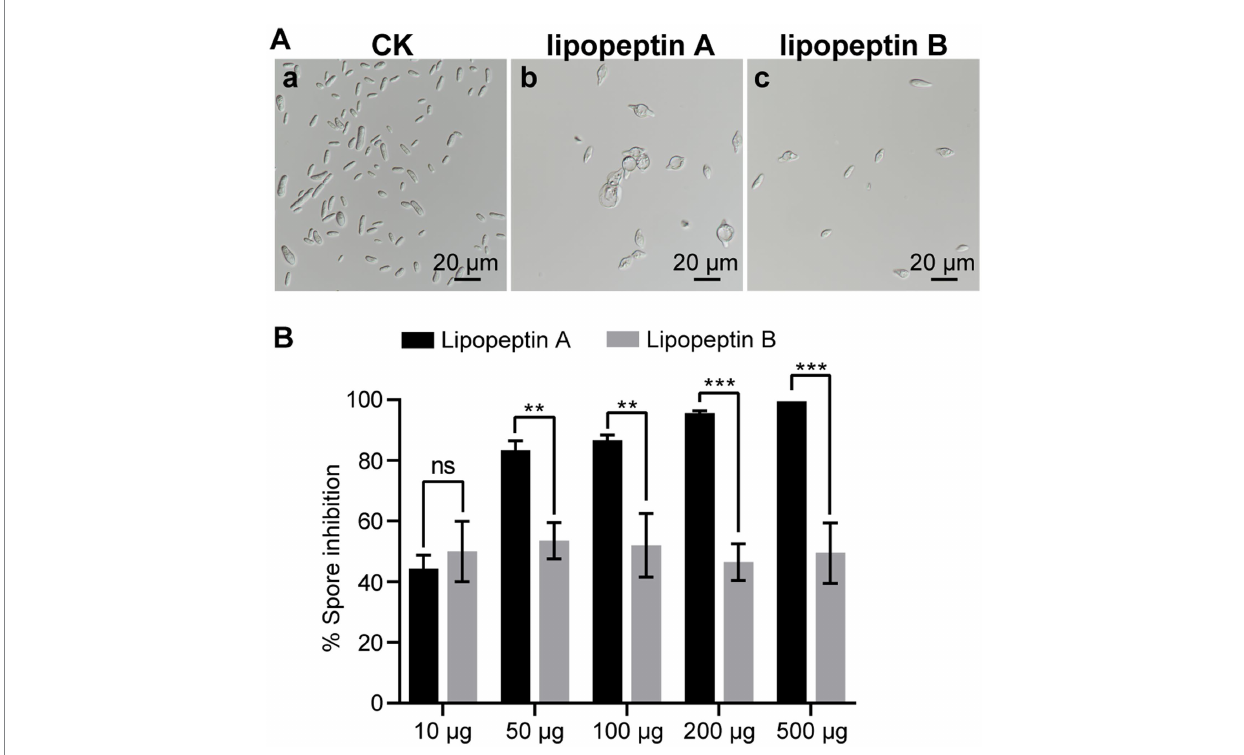
FIGURE 5 Comparative antifungal effect of lipopeptin A and lipopeptin B on spore morphology (A) and sporulation (B) of Foc TR4 cells. CK, lipopeptin A and lipopeptin B in panel (A) represent Foc TR4 spores treated with 50 μ g/mL blank culture medium, 50 μ g/mL lipopeptin A, and 50 μ g/mL lipopeptin B, respectively. The percentage of spore inhibition was calculated relative to CK. Values are presented as mean ± SD ( n ≥ 3). * Indicates significant differences between two groups ( t -test, * p < 0.05, ** p < 0.01, *** p < 0.001). ns = not significant.